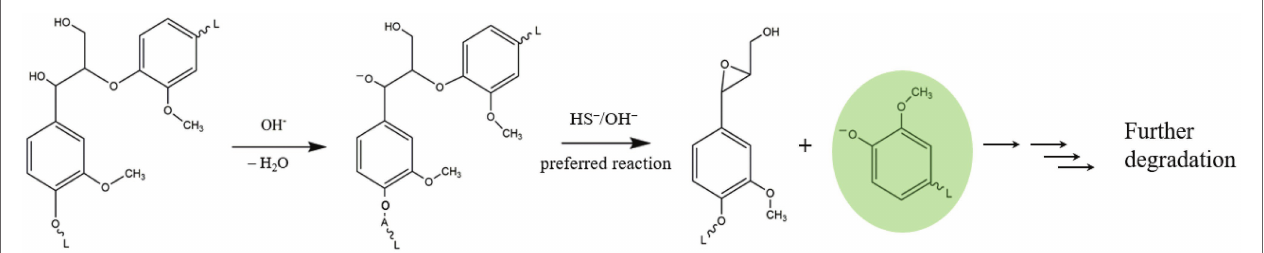
FIGURE 2 | The cleavage of β aryl ether bonds under alkaline